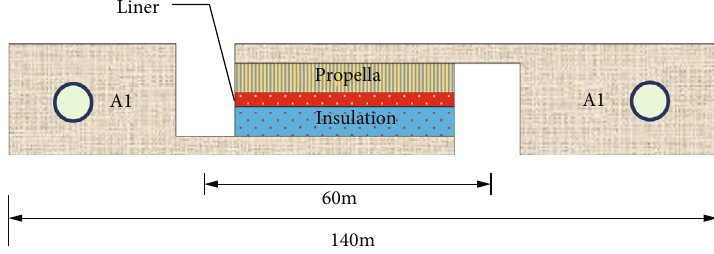
Figure 15: Geometry of the DCB test for the propellant and insulation interface.